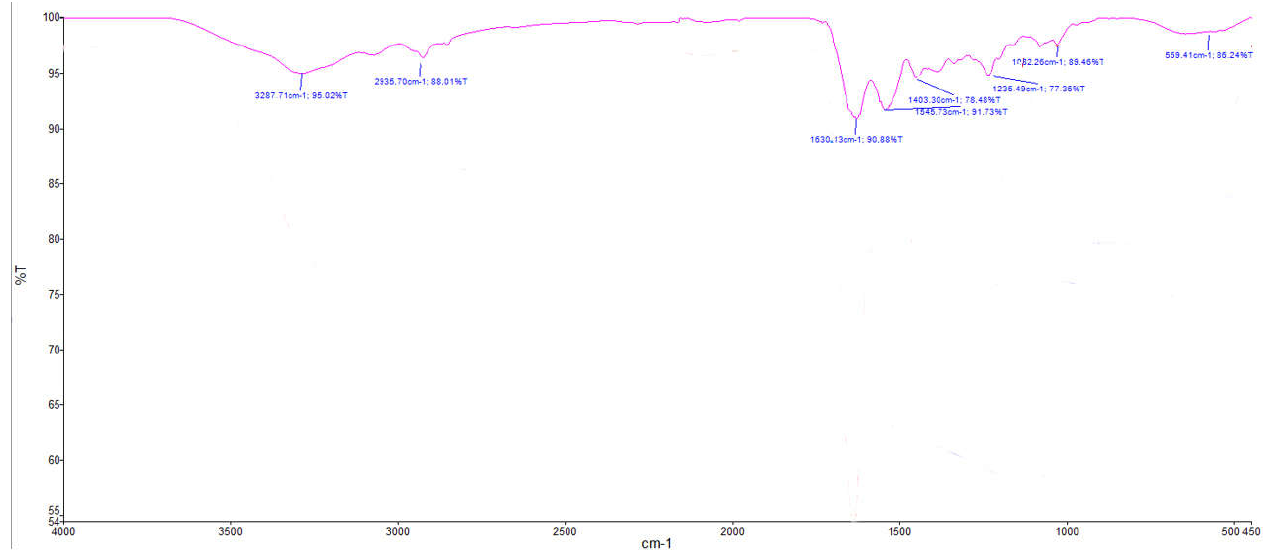
Figure 2. IR spectroscopy of collagen scaffold obtained from Dosidicus gigas Pink curve is the Dosidicus gigas collagen scaffold